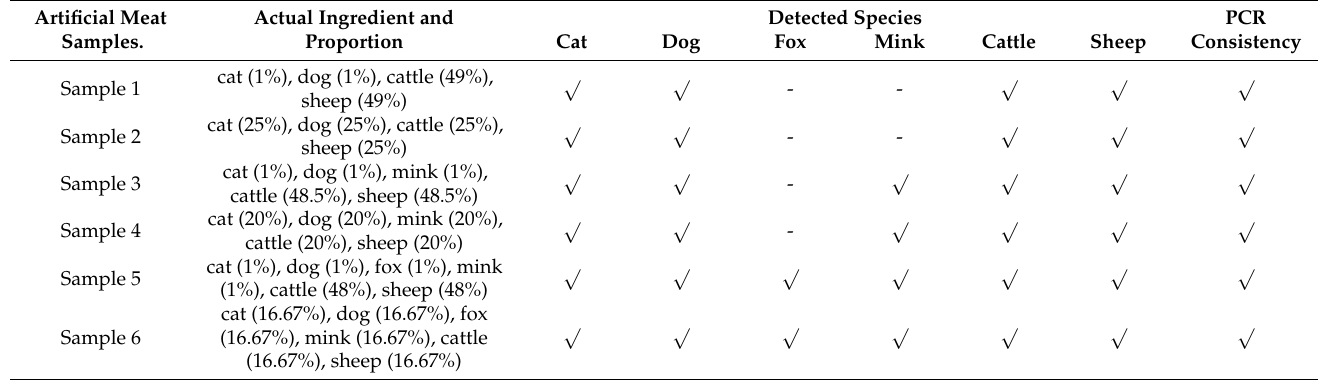
Table 3. Analysis of six artificial meat